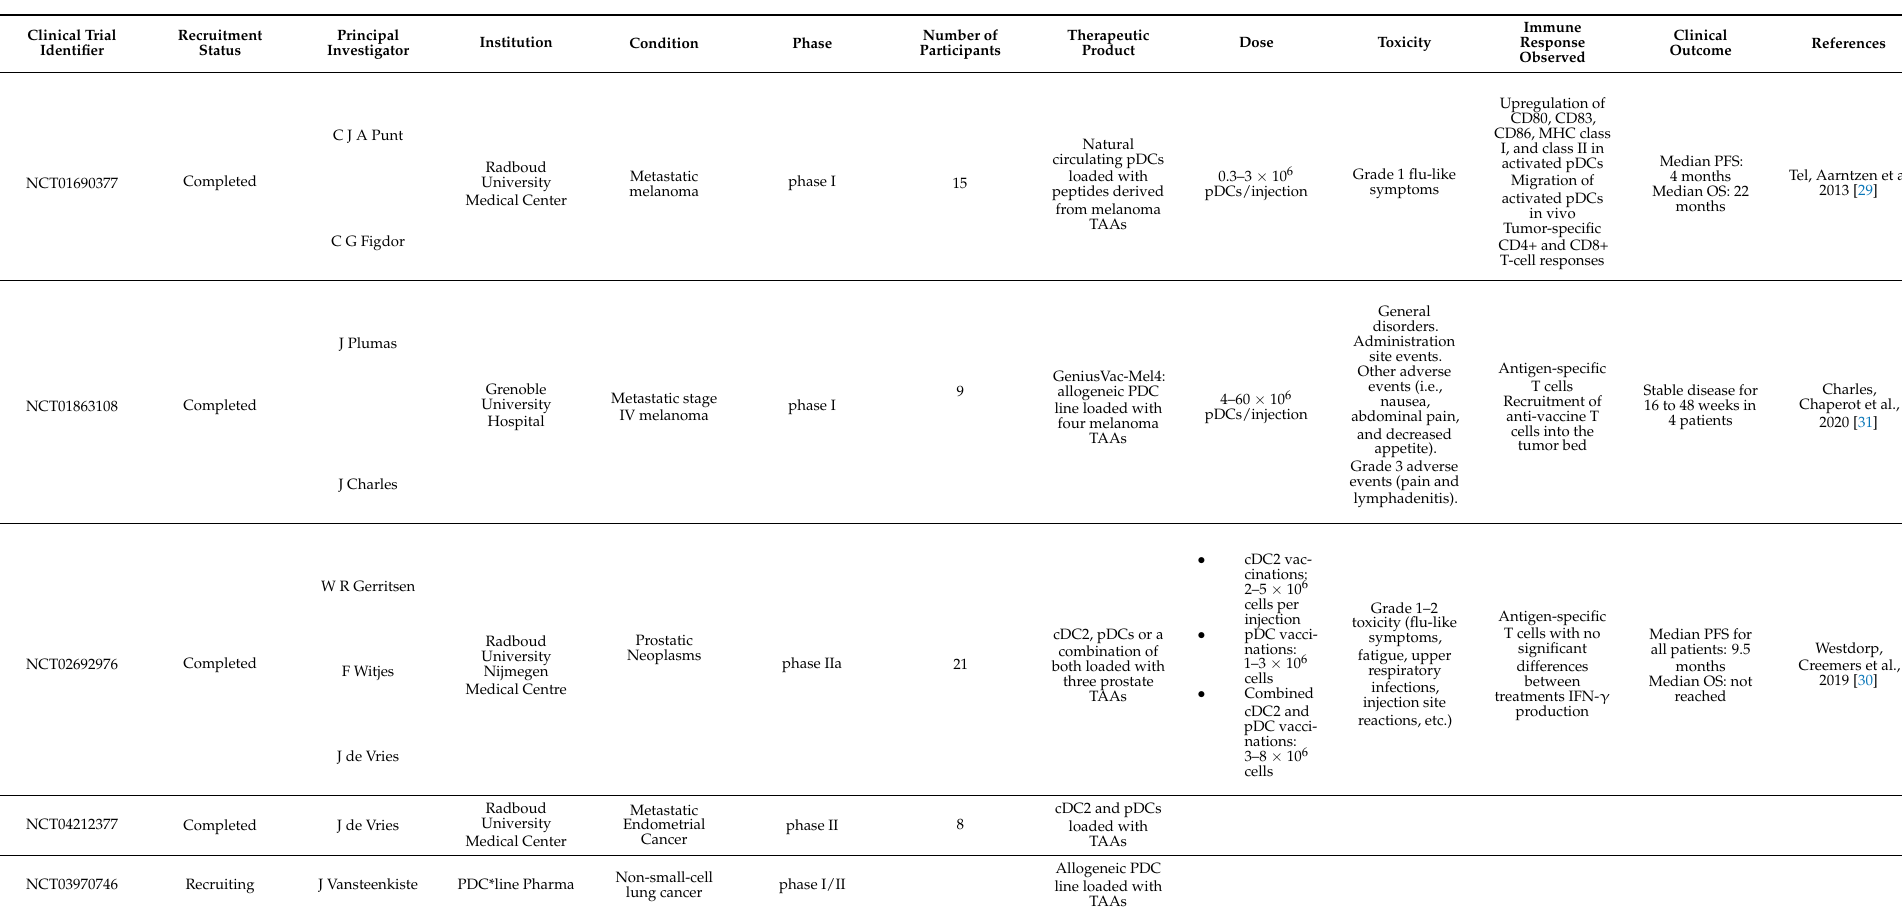
Table 1. Clinical trials evaluating adoptive transfer of pDCs as a cell therapy platform for anti-tumor vaccine